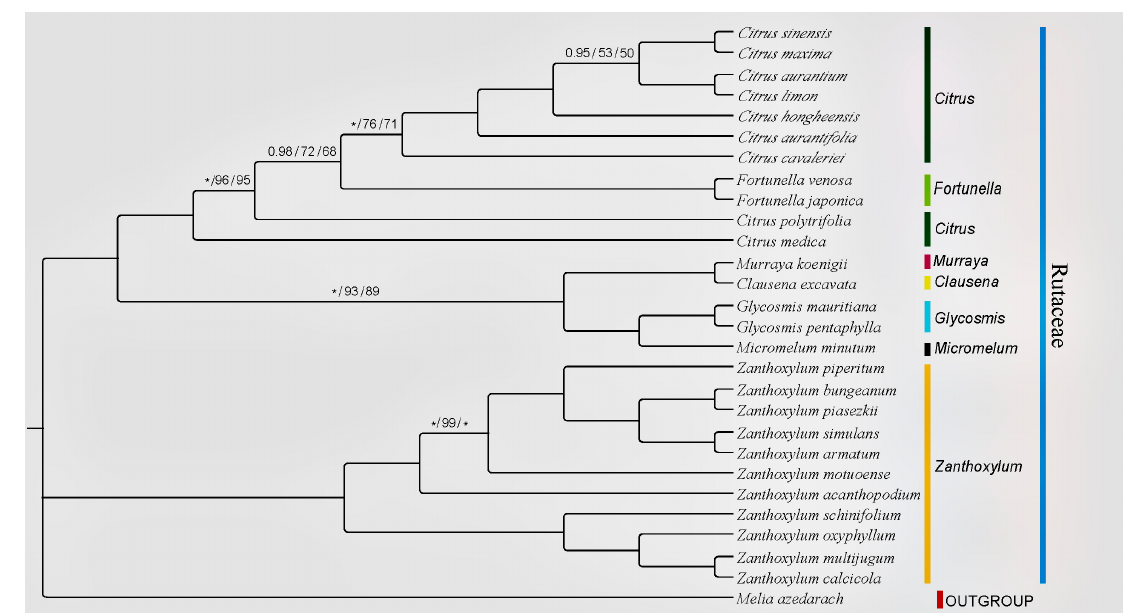
Figure 9. Phylogenetic tree generation using 76 CDS common in 27 Rutaceae species. Melia azedarach were used as outgroups. The numbers above the branch represent bootstrap support value for BI/ML/PhyML methods, where the asterisk signifies maximum support value of 100 in IQ and 1 BI. Blank branches signify 100% support value.